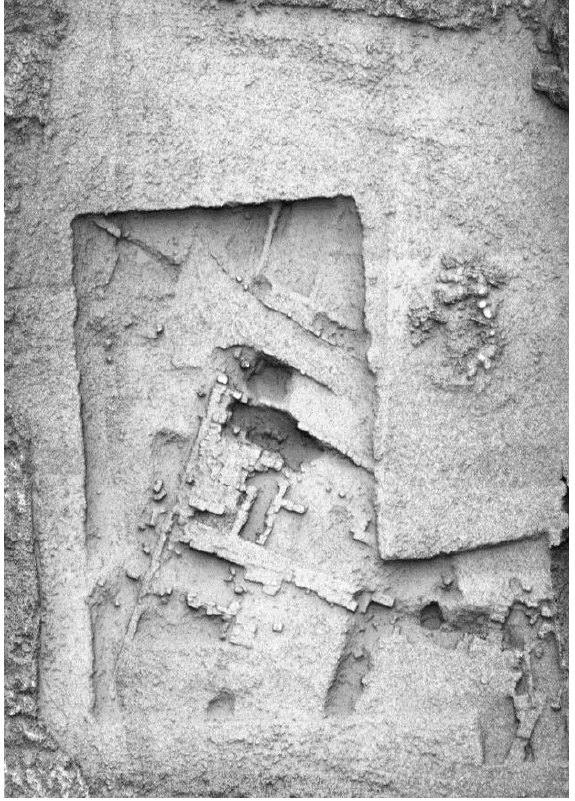
Figure 3: Micmac matching results with the UAV images over Veio, visualized in shaded mode.